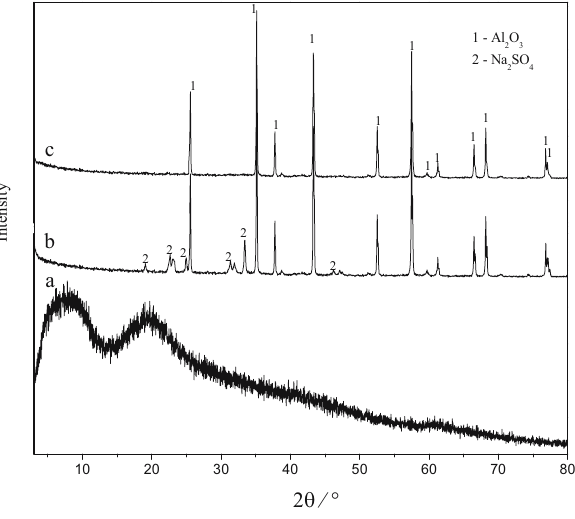
Figure 8: XRD patterns of aluminum - containing samples during